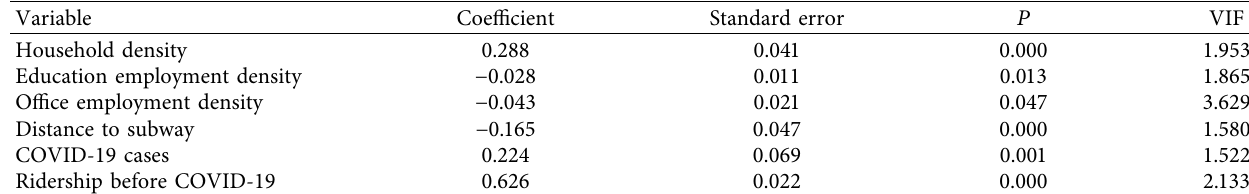
Table 3: MLR model results.